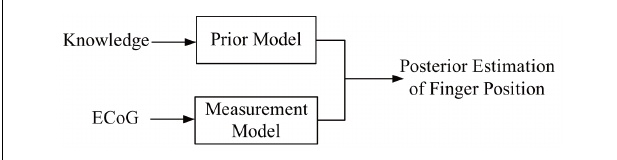
FIGURE 2 |The schematic diagram of Bayesian